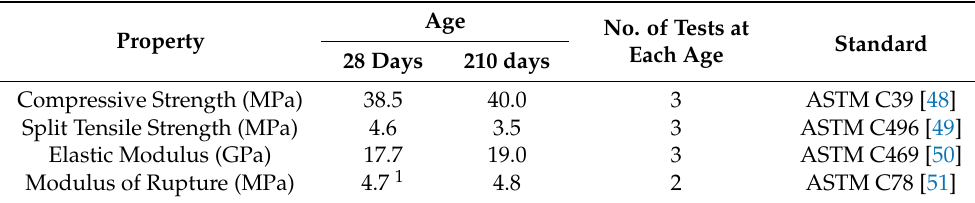
Table 4. Mechanical properties of